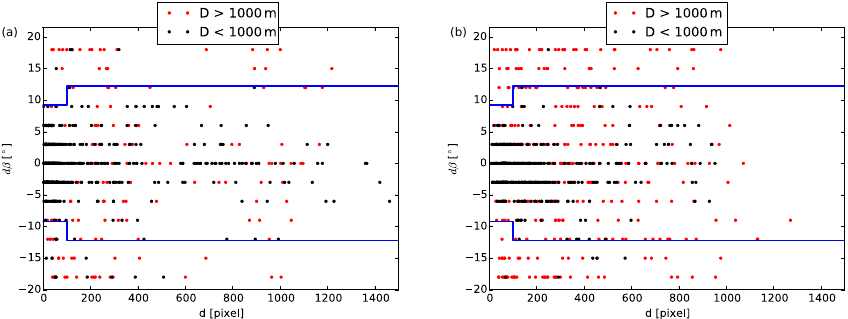
Figure 11. Pattern-matching rotation adjustment dβ vs. distance d to closest feature-tracking vector using (a) HV and (b) HH polarisation. D represents the difference between buoy GPS position and algorithm result. The blue lines indicate the recommended setting for β (Eq. 14) with d min = 10 and d max =